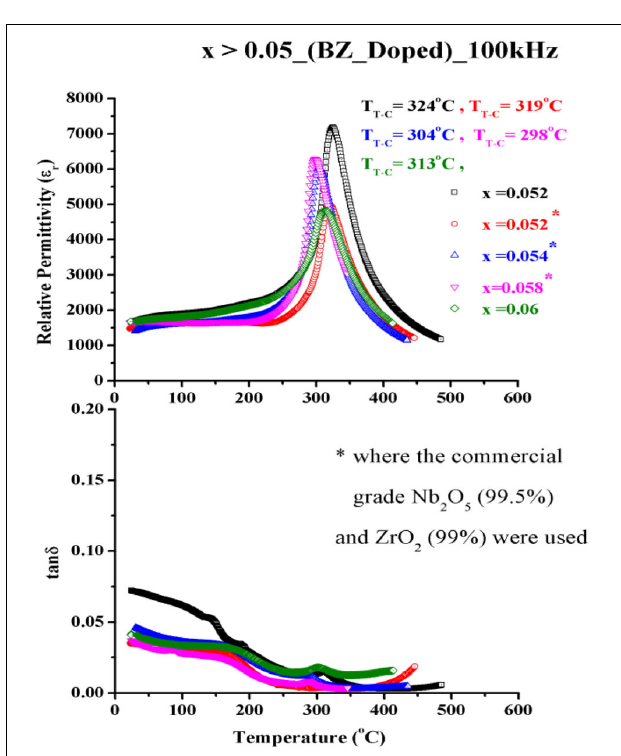
FIGURE 5 | Pellet sample made of commercial grade raw materials of 0.942KNN-0.058BNZ formulation showing relative permittivity and tan δ loss at frequency of 1 kHz–1